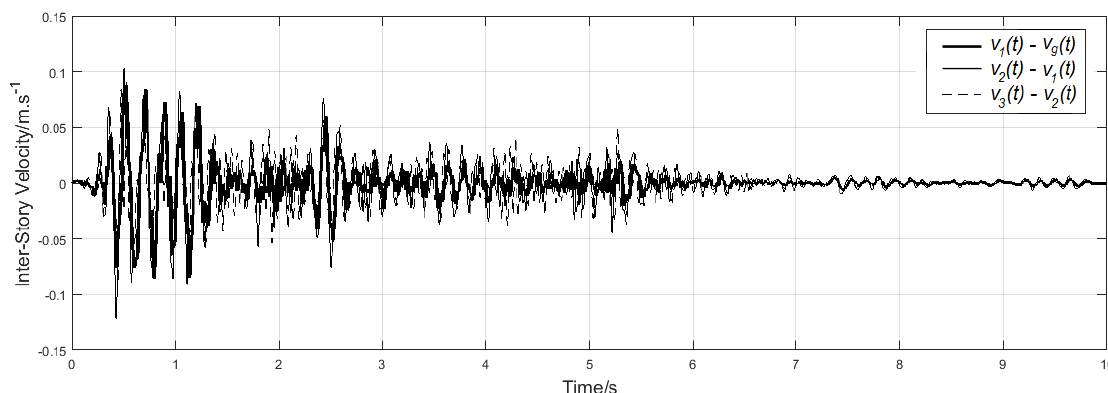
Figure 13. Inter-storey drift, under seismic excitation, using the particle swarm optimization (PSO)/BELBIC controller.